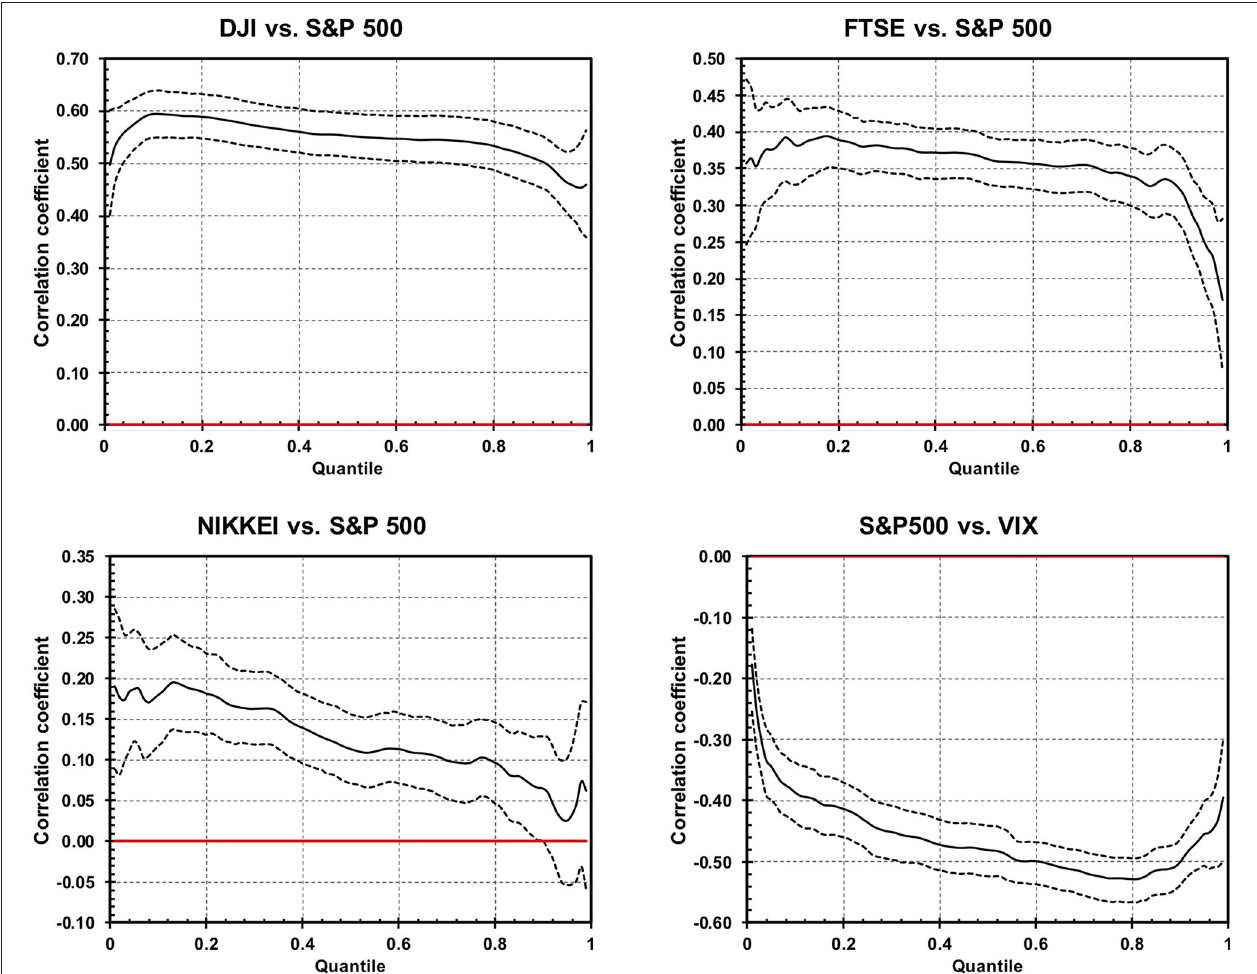
FIGURE 4 | Quantile correlations of the S&P 500 with other assets. The notation from Figure 2